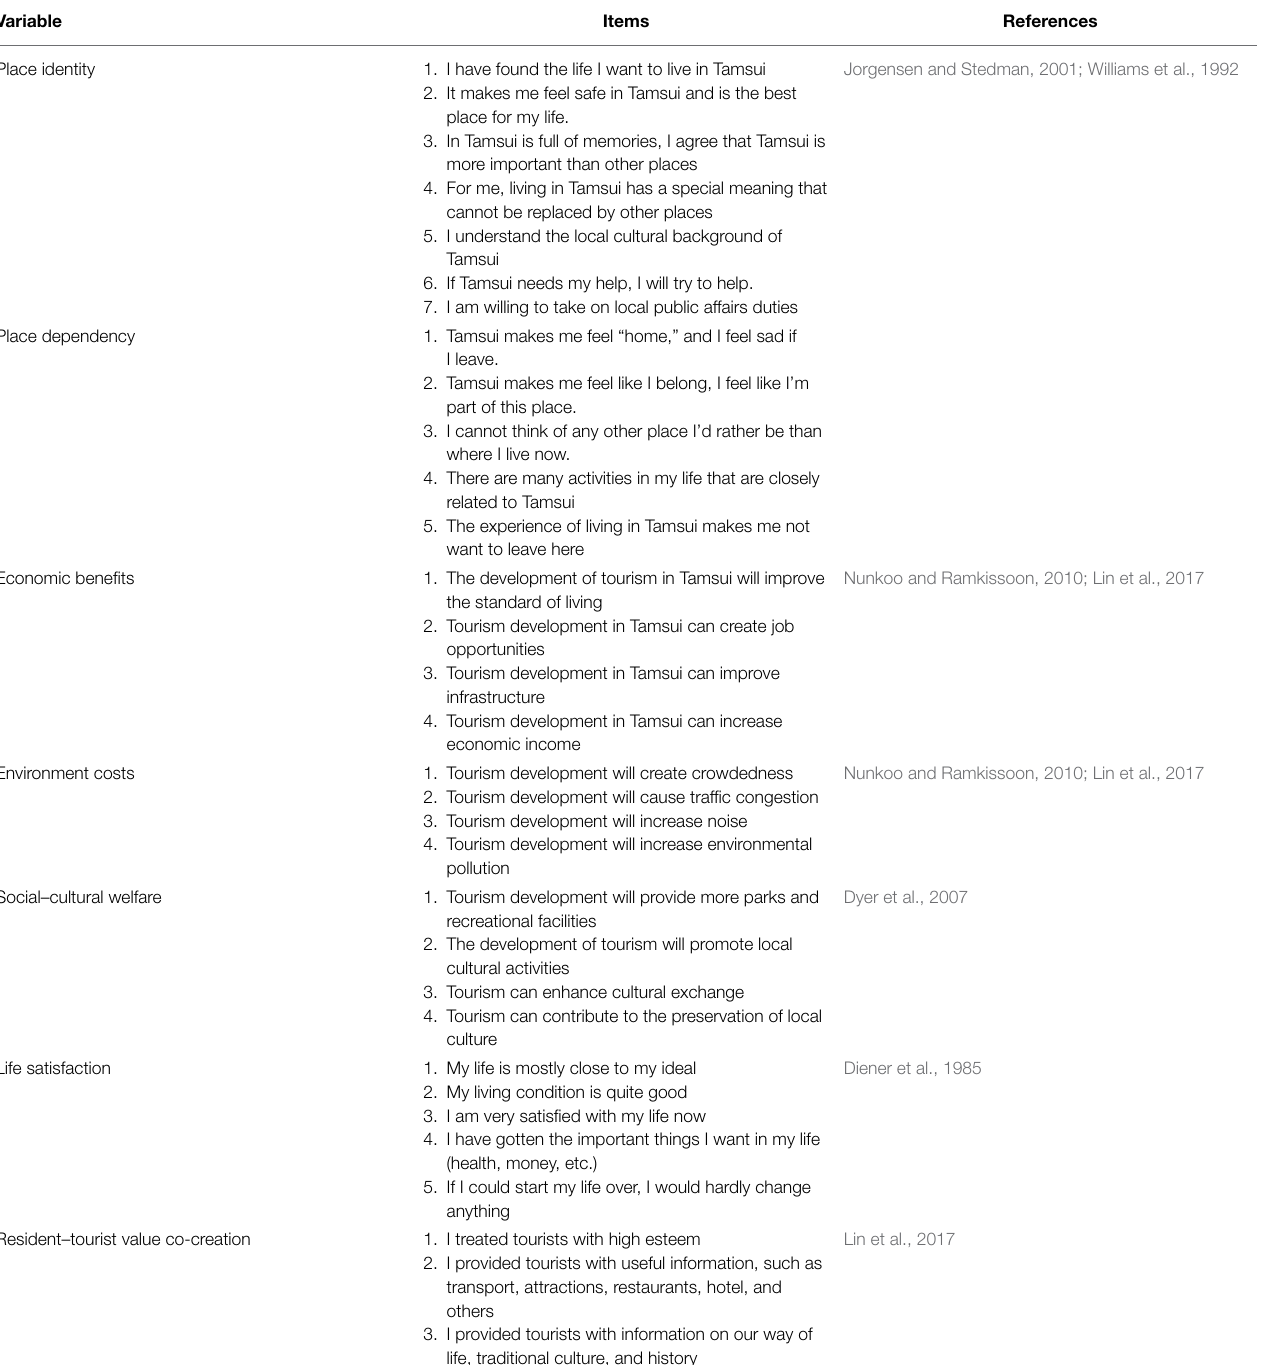
TABLE 2 | Questionnaire items and